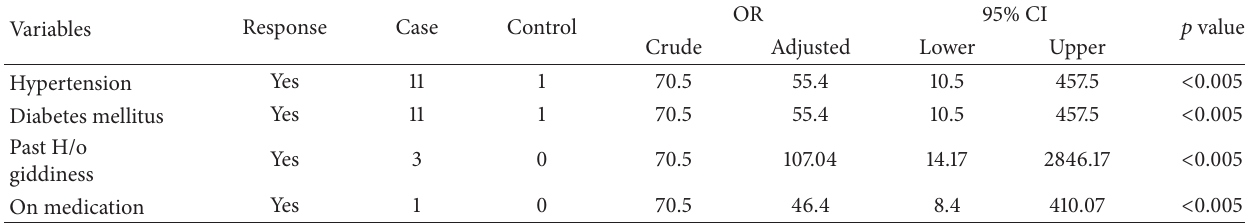
Table 7: Factors affecting the efficacy of Epley’s maneuver among BPPV